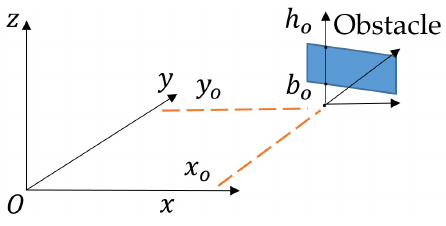
Figure 16. A scene with its